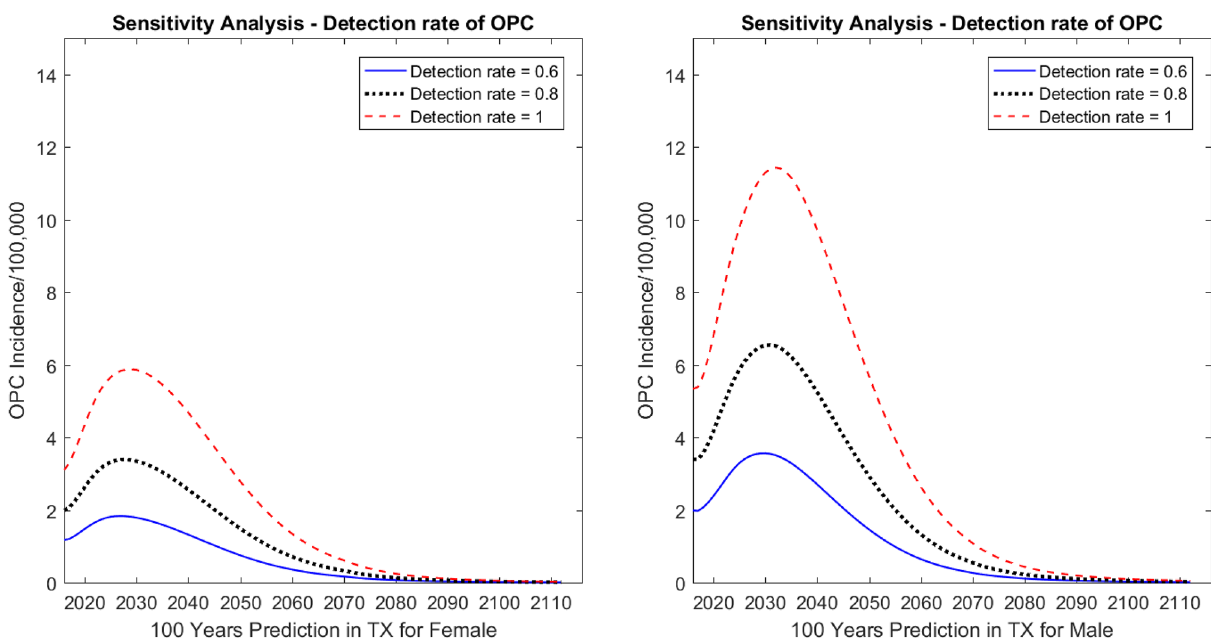
Figure 6. Sensitivity analysis: predicted effect of detection rate on oropharyngeal cancer (OPC) incidence in Texas (TX). The graph on the left shows predictions for females; the graph on the right shows predictions for males.